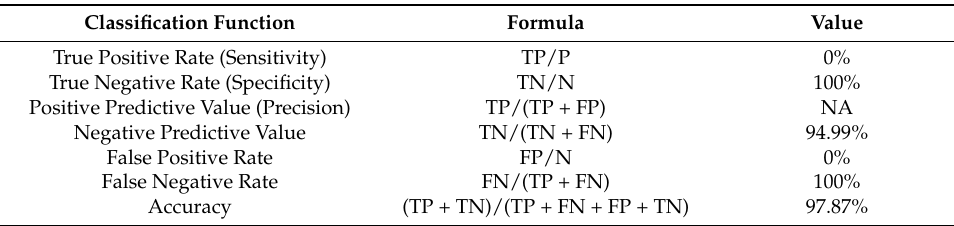
Table 7. Classification functions for model. TP = True Positive; P = Positive Instances; TN = True Negative; N = Negative Instances; FP = False Positive and; FN = False Negative. NA= not applicable (TP and FP are = 0).